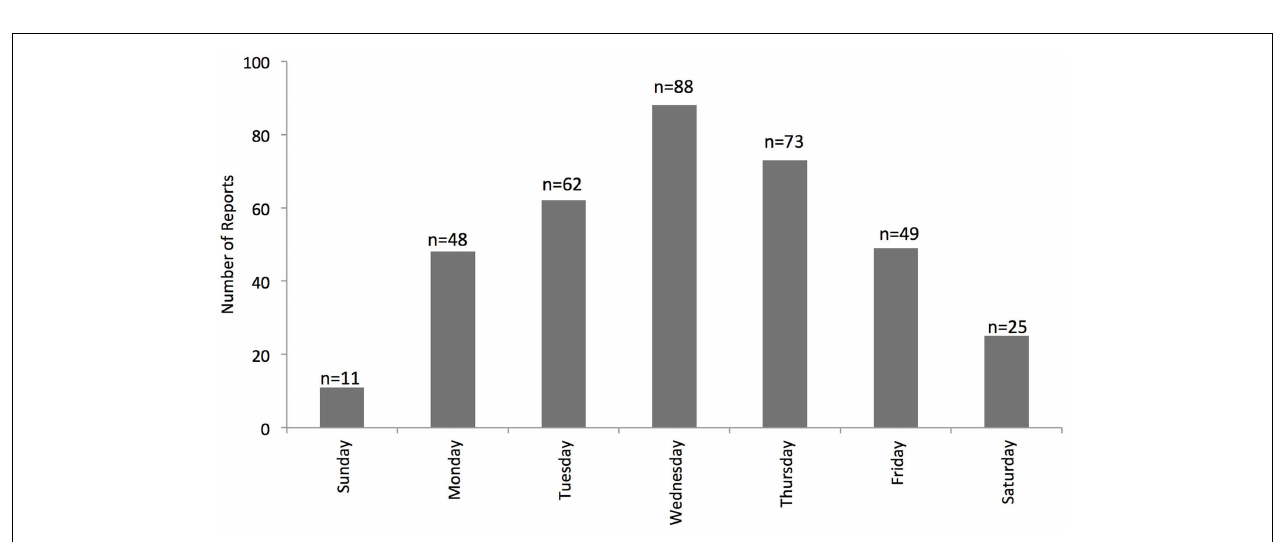
FIGURE 3 | Day of week trends for citizen reports of collisions and near misses